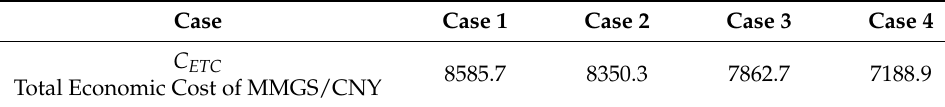
Table 6. The final economic cost of MMGS in four cases.